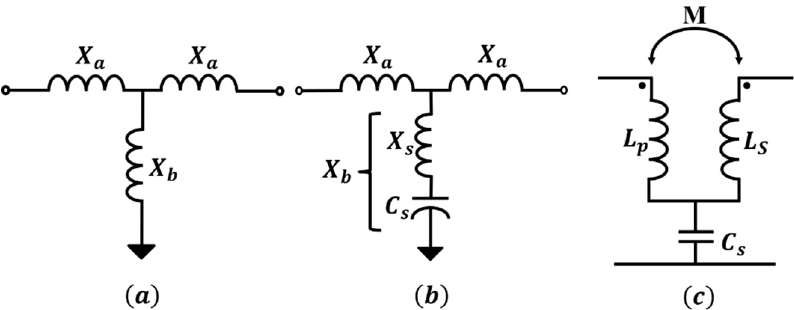
Figure 6. ( a ) Reactive Tee Network used in the K-Inverter equivalent from Figure 4b. ( b ) A Standard